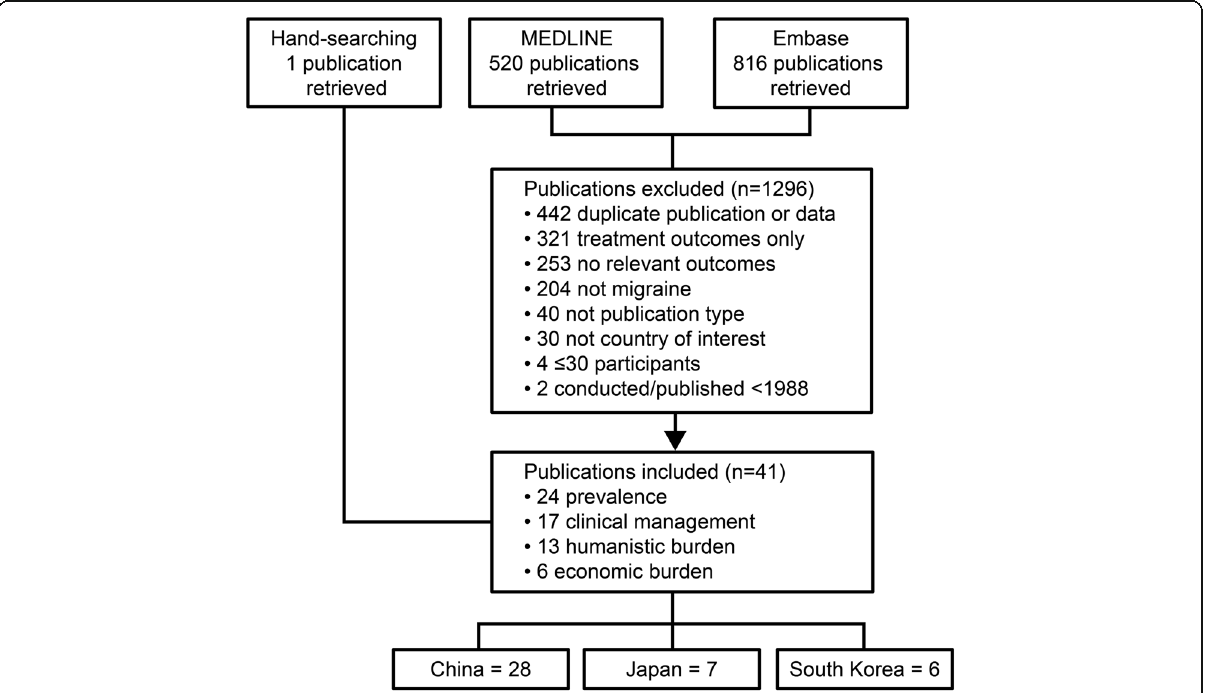
Fig. 1 Publication flow Note: publications were excluded for 1 reason but may have met > 1 exclusion criterion; most included publications reported outcomes for ≥ 2